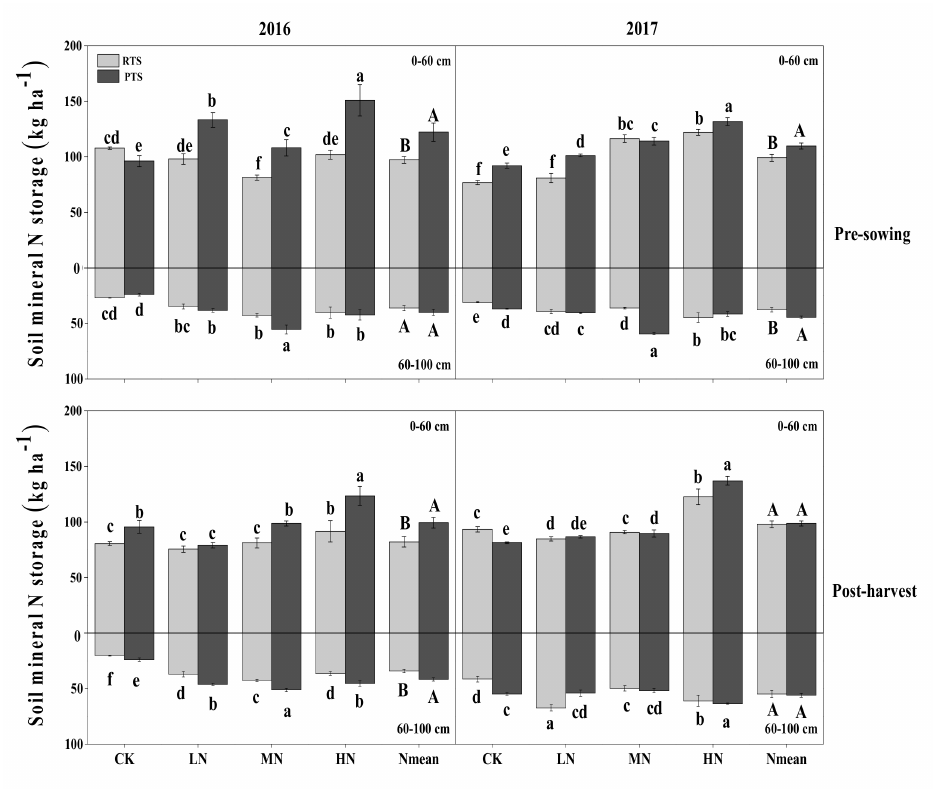
Figure 2. Response of soil mineral N storage to tillage with straw incorporation and N treatment in 2016–2017. RTS, rotary tillage with straw incorporation; PTS, plow tillage with straw incorporation. CK, LN, MN, and HN indicate 0, 112, 187, and 262 kg N ha − 1 applied, respectively. Nmean, the mean values of di ff erent N. Di ff erent uppercase and lowercase letters indicate significant di ff erences for soil mineral N storage between tillage with straw incorporation regimes and N levels for p < 0.05 level,